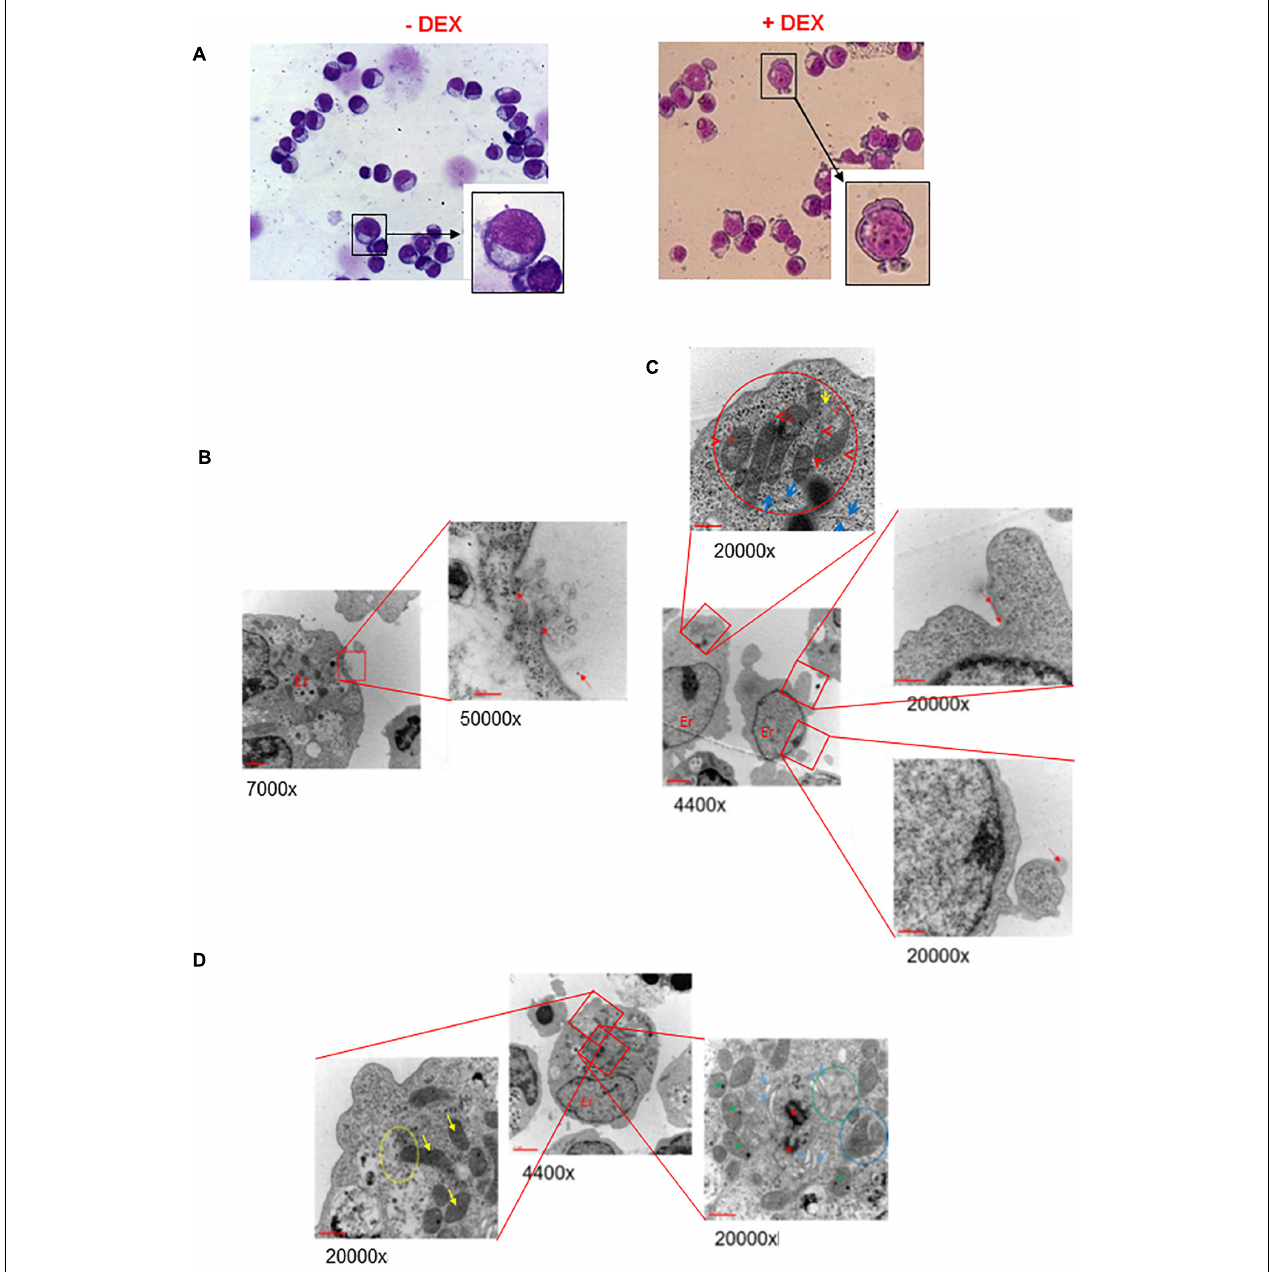
FIGURE 1 | Ex vivo generated erythroblasts present morphological evidence of plasma and mitochondrial membrane damage. (A) The erythroblasts plasma membrane presents numerous pebbles. May-Grunwald-staining of representative cytospin preparations of erythroblasts from days 10 HEMA def culture obtained with and without Dex, as indicated. Representative pro-erythroblasts are shown at higher magnifications in the inserts. Original magnification 40X. (B,C) The membrane pebbles present ultrastructural features associated with exosome and micro-particle release. Electron microscopy analyses of the pebbles on the plasma membrane of representative pro-erythroblasts from days 10 HEMA def with Dex. (B) At greater magnification, the pebble, probably a multivesicular body, shows eruption of the plasma membrane with extrusion of exosomes and free ribosomes (red arrows). (C) At greater magnification, the pebble shows the presence of membrane leaking (red arrows) and release of micro-particles (panel of the bottom). Greater magnification of this pro-erythroblast (panel on the top) also shows the localization of the mitochondria at a pole of the cytoplasm, the mitochondria body. In addition, the mitochondria present morphological sign of distress (red circle) while the cisterns of the surrounding rough endoplasmic reticulum present numerous traits deprived of ribosomes (blue arrows). (D) The mitochondria from erythroblasts cultured with Dex present several abnormalities of the crest membranes. Electron microscopic analyses of a representative pro-erythroblast showing at greater magnification that the mitochondria present several crest abnormalities (reduction in number, diameter larger than normal and membrane ruptures). Only the most external mitochondria (yellow circle) appears partially fused with a phagosome (yellow arrow, bottom left panel). The panel on the right shows fusion among mitochondria (blue circle). Red asterisks indicate centrioles and green asterisks autophagy vesicles. Original magnifications are indicated below each panel.